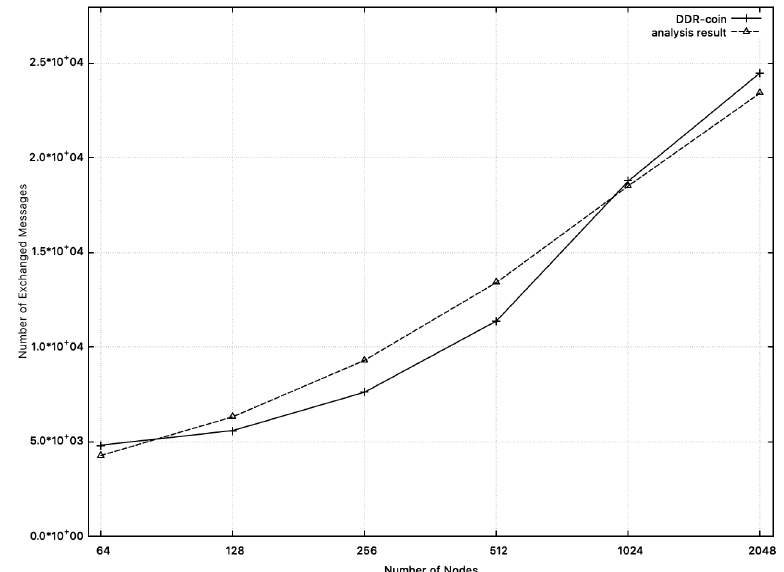
Figure 9. Message complexity: the measured numbers from simulations and the analysis results from Section 3 when n = 2 6 ∼ 2 11 , w = 10,000. The solid line represents message complexity measured from simulation. The dotted line (analysis results) represents the function: 55 · n log